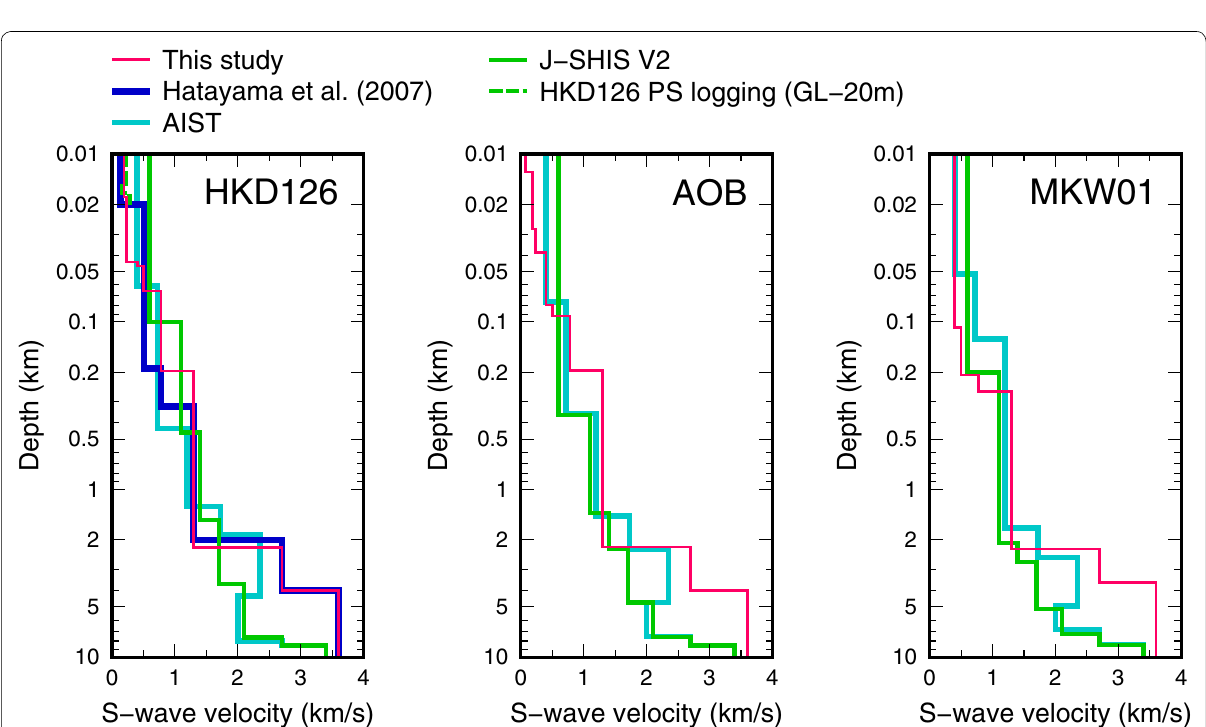
Fig. 9 Estimated S-wave velocity structures at three sites. The existing structures are also indicated for each site. a HKD126, b AOB, c